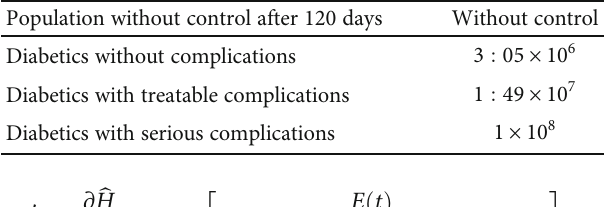
Table 2: Evolution of number of diabetics without control after 120 days.